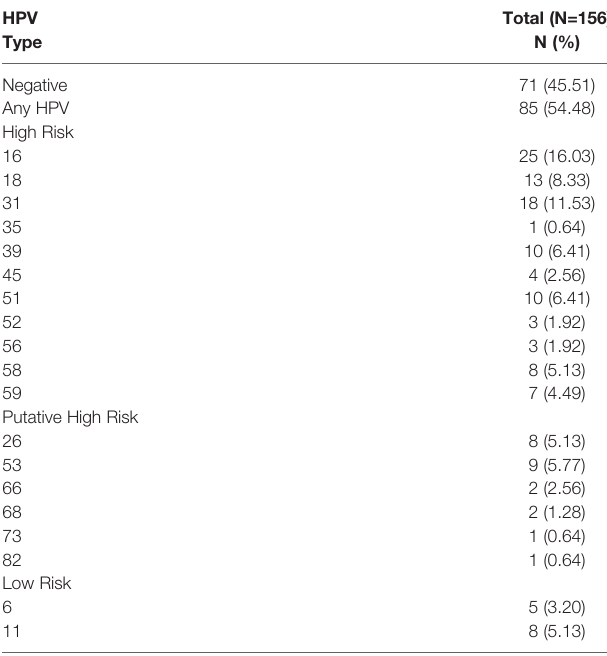
TABLE 1 | HPV prevalence and genotype distribution in women with symptomatic cervical ectopy.